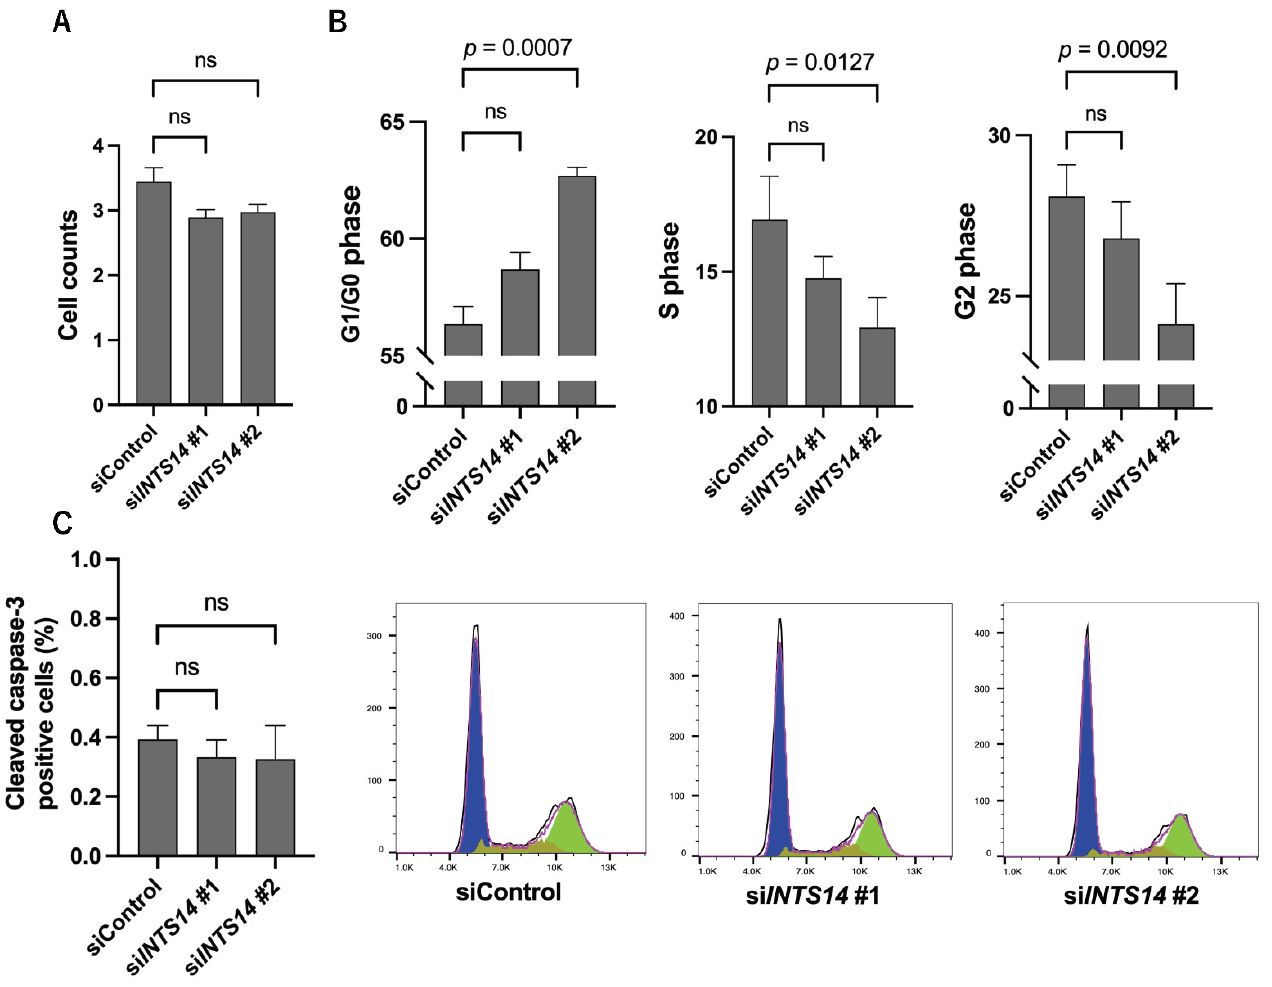
Figure 5. Knockdown of INTS14 causes G0/1 arrest in PC-3 cells. ( A ) PC-3 cell count following INTS14 knockdown by siRNA transfection. ( B ) Cell cycle assay of INTS14 knockdown by siRNA transfection in PC-3 cells. ( C ) Apoptosis analysis of INTS14 knockdown by siRNA transfection in PC-3 cells. The values shown are the means ± SEM (n = 3). Not significant (ns).